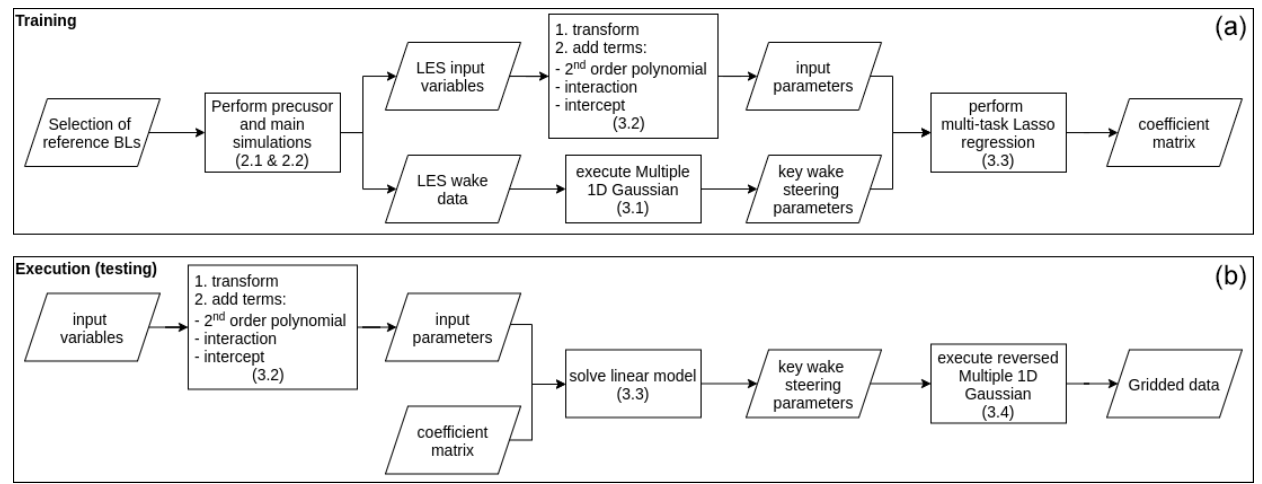
Figure 3. Flowchart describing the training (a) and execution (b) procedure of DART. The section in which the process is described is indicated in parentheses. The coefficient matrix generated in (a) is used in (b) .